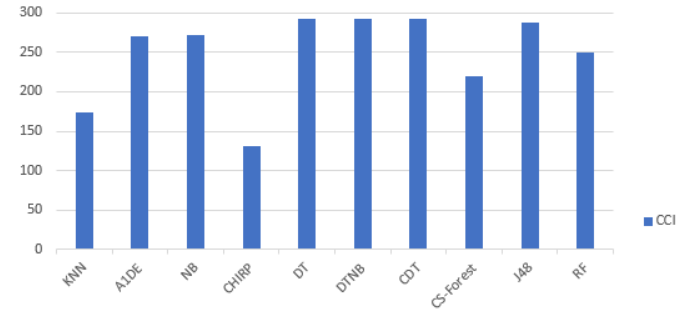
Figure 7. CCI analysis of individual